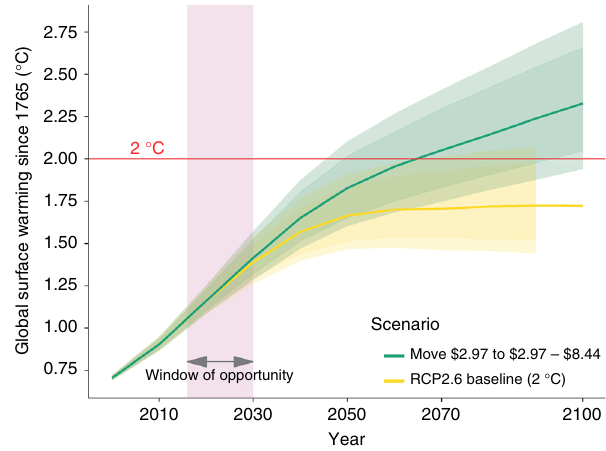
Fig. 3 Predicted increases in global temperature of different scenarios moving poorest to the global middle class. Move global poor ( < 2.97$PPP per day) to next higher income category 2.97 – 8.44$ PPP per day. The green line shows the warming determined by moving the less-than-2.97